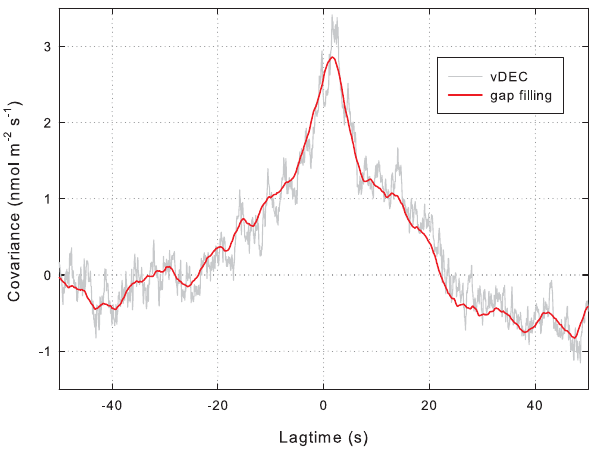
Fig. 3. Example (9 September 2008 10:45CET) for the time de- lay between the methanol time series and the vertical wind veloc- ity. Maximum covariances, i.e. lag times were 1.60s for the vDEC method and 1.65s for the gap filling